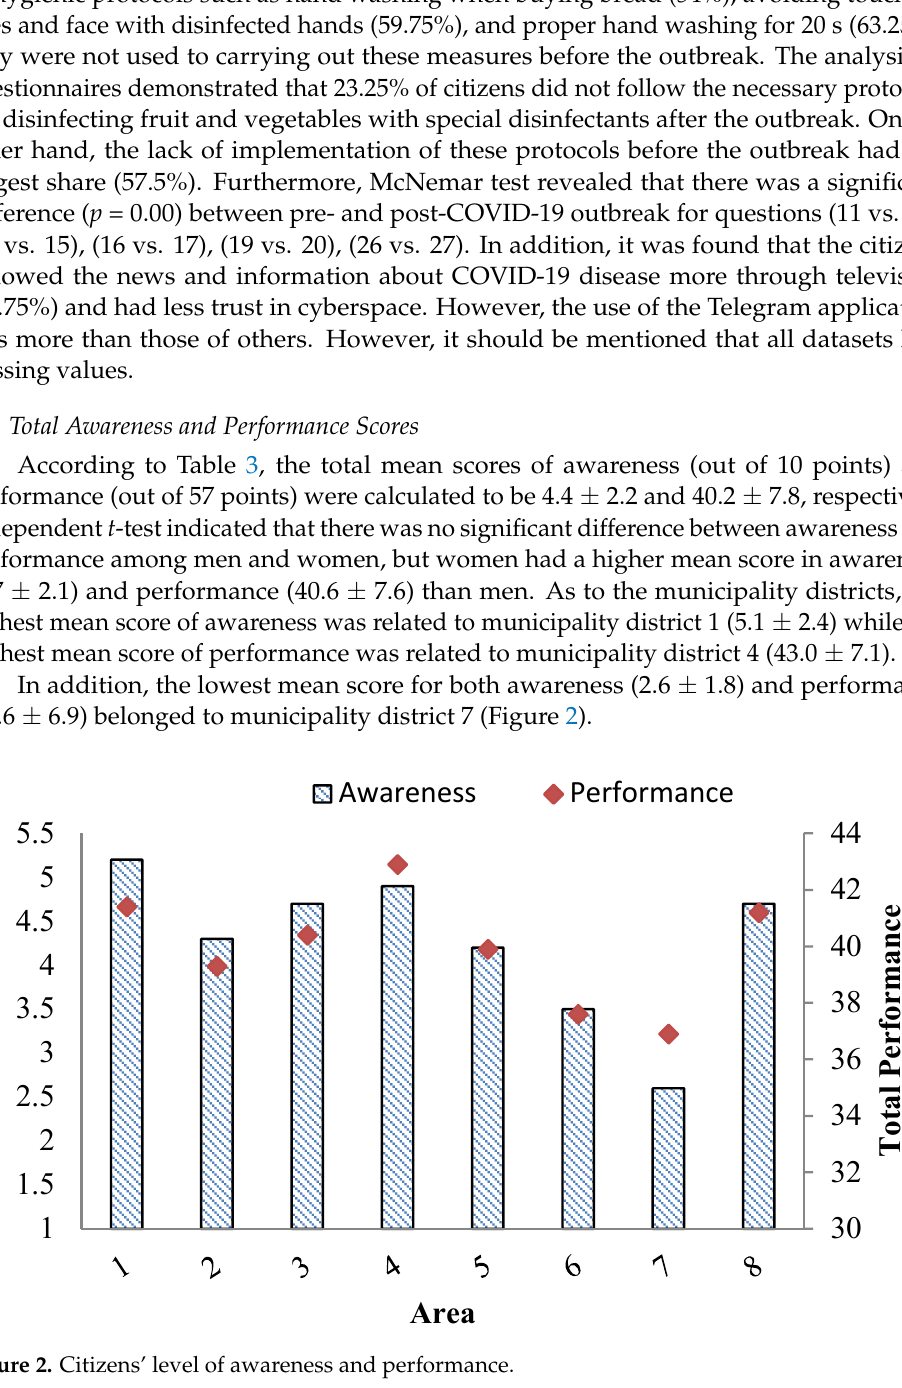
Figure 2. Citizens’ level of awareness and performance.